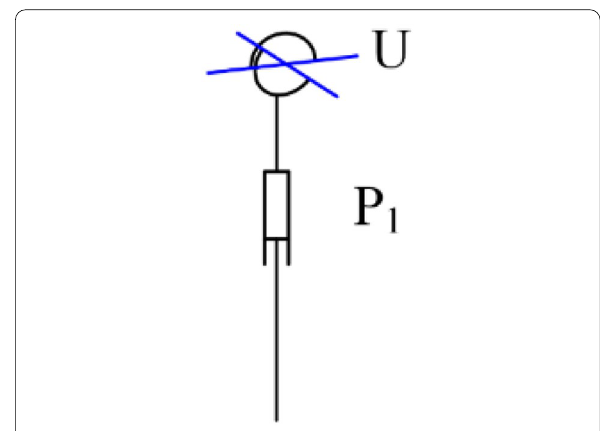
Figure 2 The P 1 U branch with three single